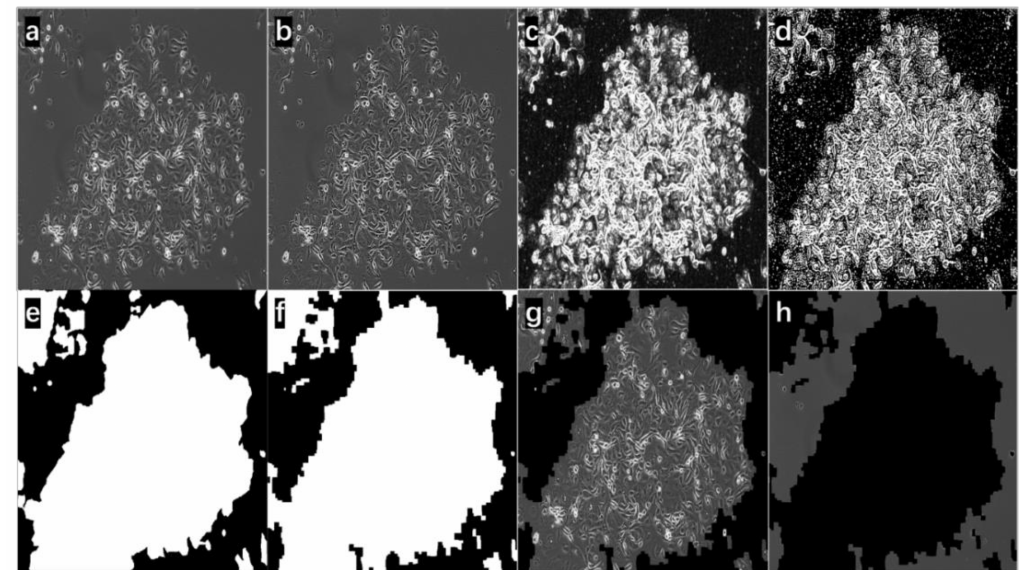
Figure 4. Cell image with high-density input. ( a ) The input image (from Input Image in Figure 1); ( b ) the sharpened image (from Sharpening and Resize in Figure 1); ( c ) the image contained all the edge information (from Grayscale Edge Image in Figure 1); ( d ) the edge image (from Otsu Binary Threshold in Figure 1); ( e ) the manually labeled binary image for comparison here; ( f ) the cell region binary mask; ( g ) the foreground image; ( h ) the background image.